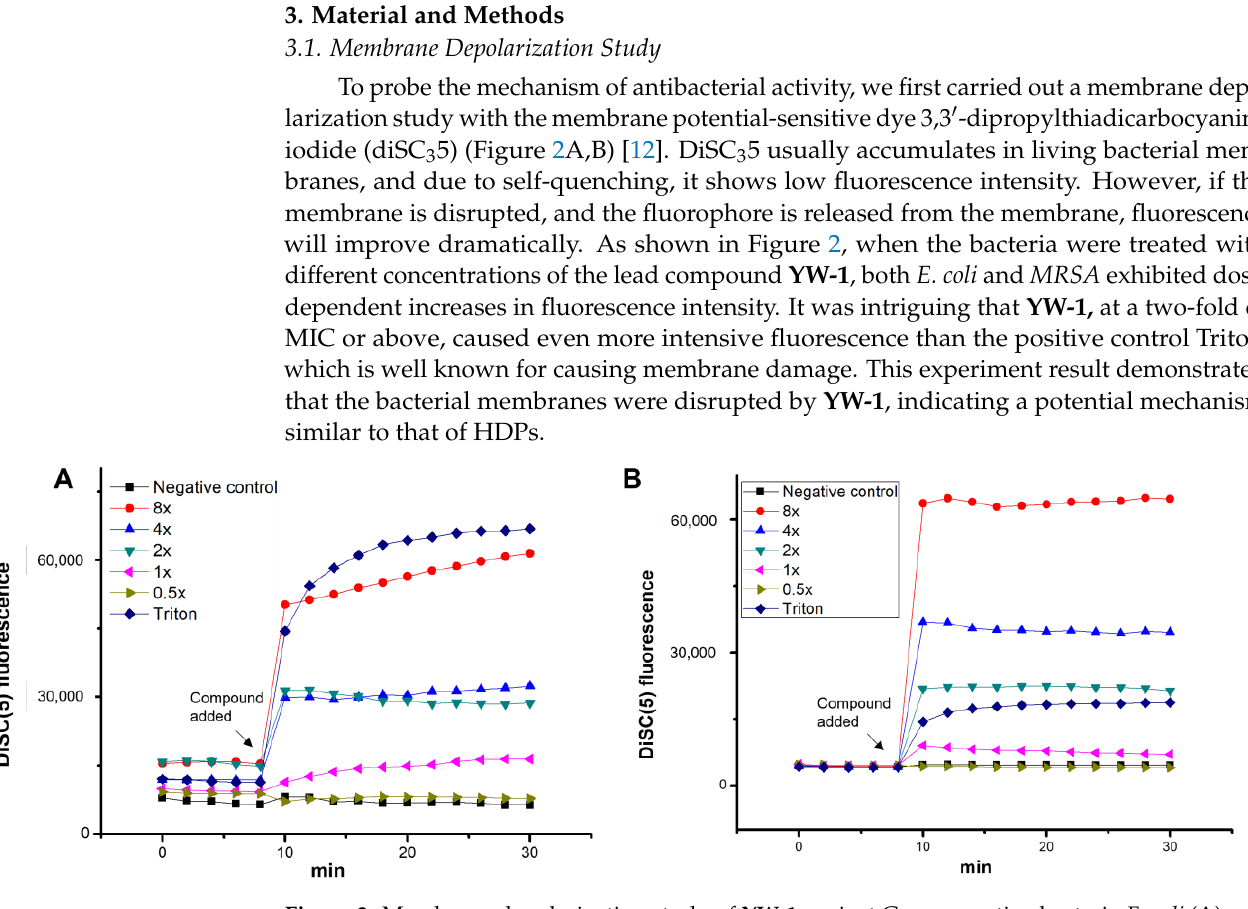
Figure 2. Membrane depolarization study of YW-1 against Gram-negative bacteria E. coli ( A ) and Gram-positive bacteria MRSA ( B ). Triton x-100 as a positive control.